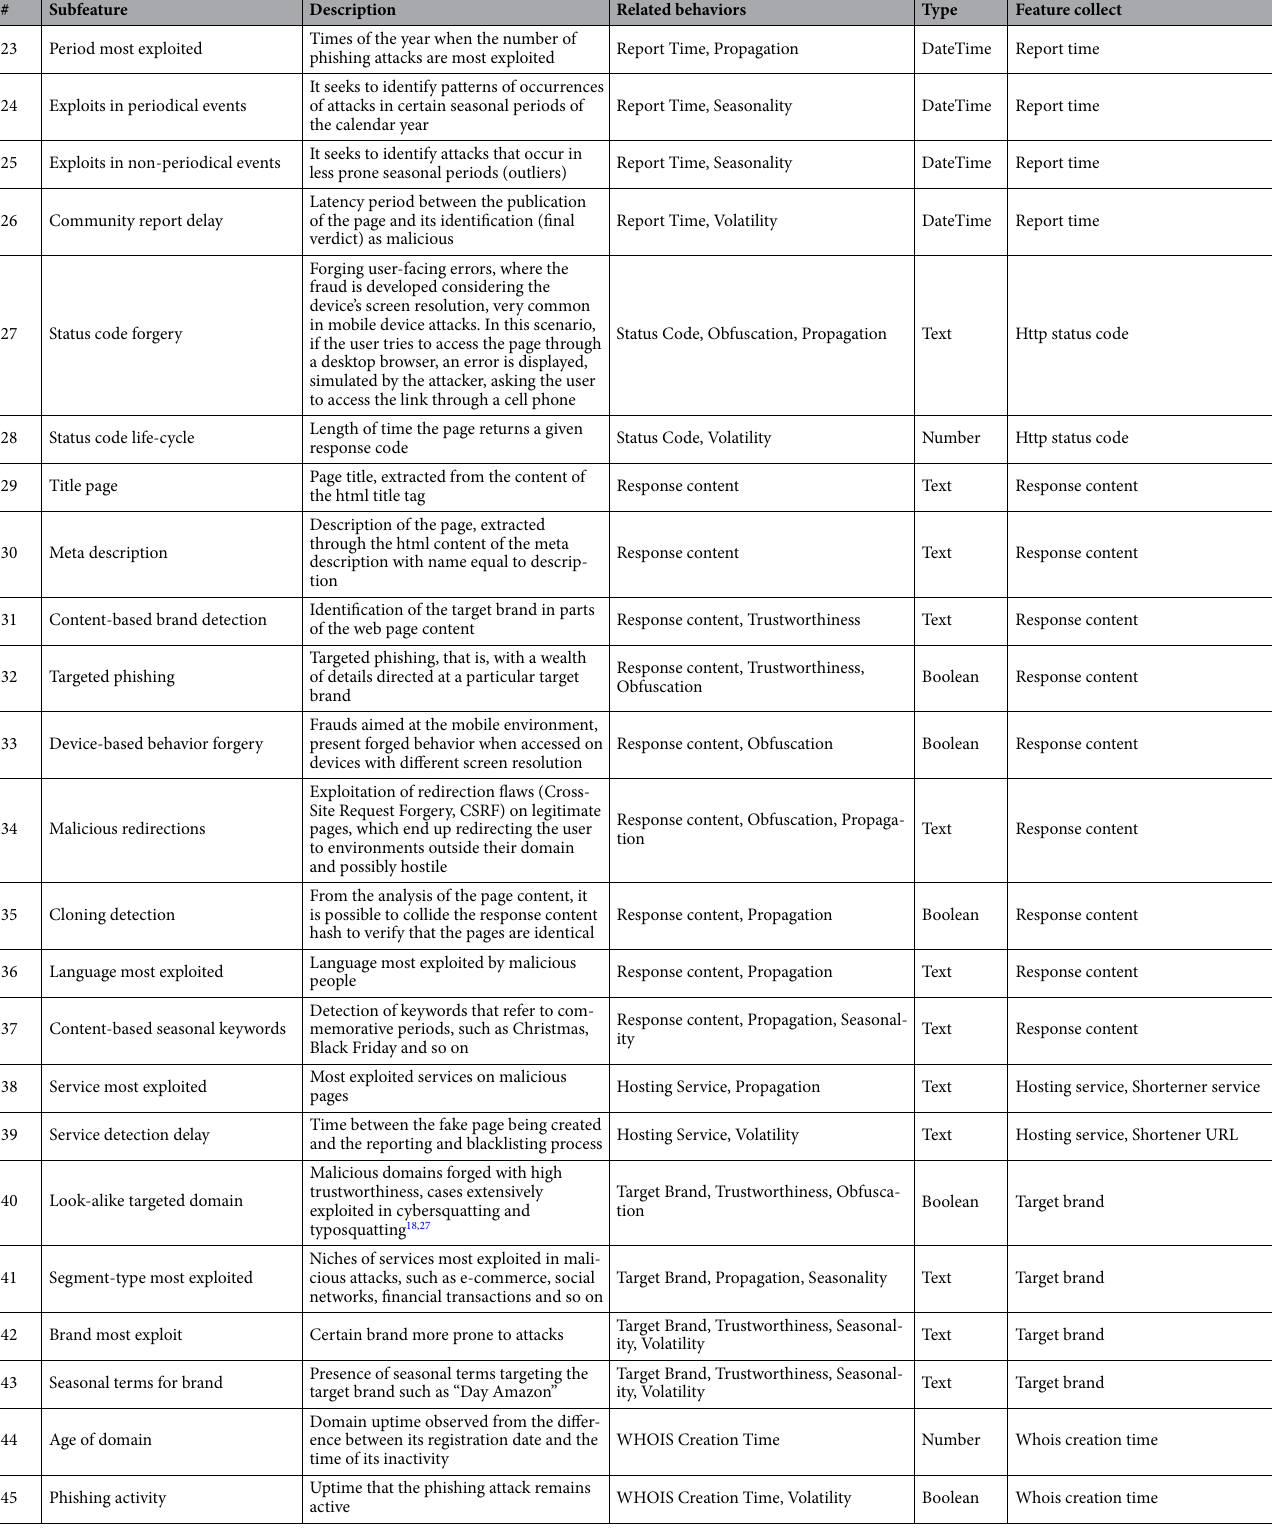
Table 7. Subeatures Definition